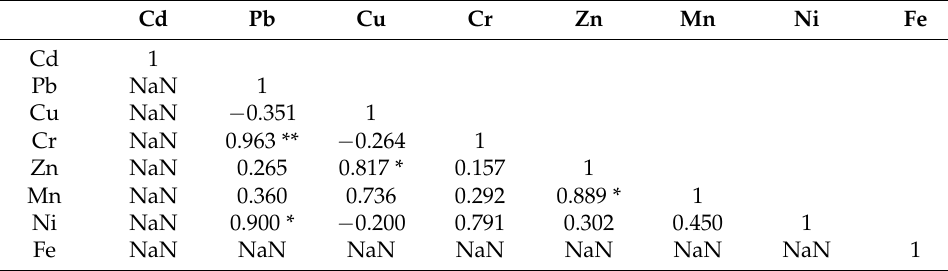
Table 5. Pearson correlation coefficients of metals in groundwater